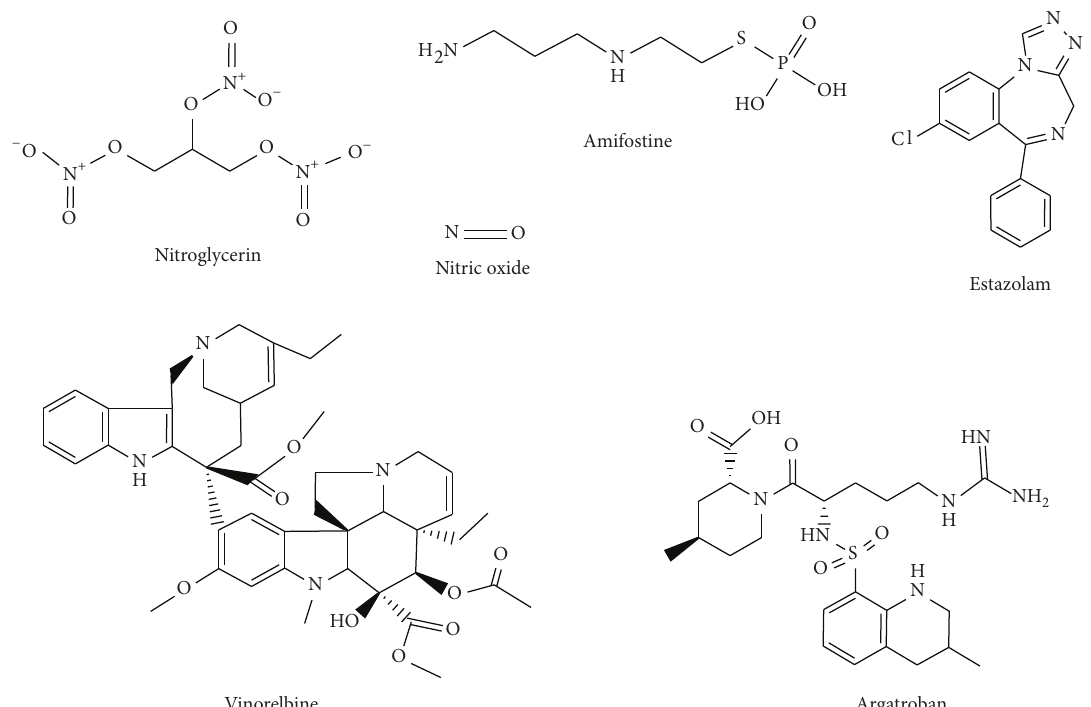
F 5: Example of differences in branching degree and, hence, in dyspnea side effect the degree of molecules conforming to the training and test